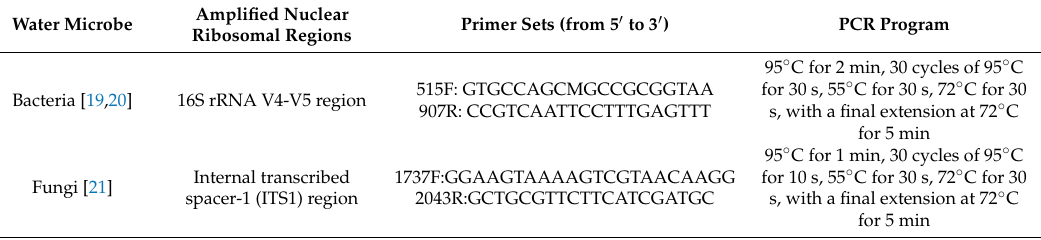
Table 1. Specific primer sets of water bacteria and fungi, and PCR program